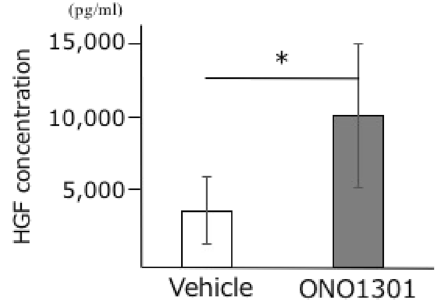
Figure 1. ONO1301 promotes the production of hepatocyte growth factor (HGF) in normal human lung fibroblast (NHLF). Exposure to ONO1301 (100 nM) led to a significant increase in the secretion of HGF in the culture supernatant of NHLF at 72 h, as measured by ELISA. n = 5. * P < 0.05.